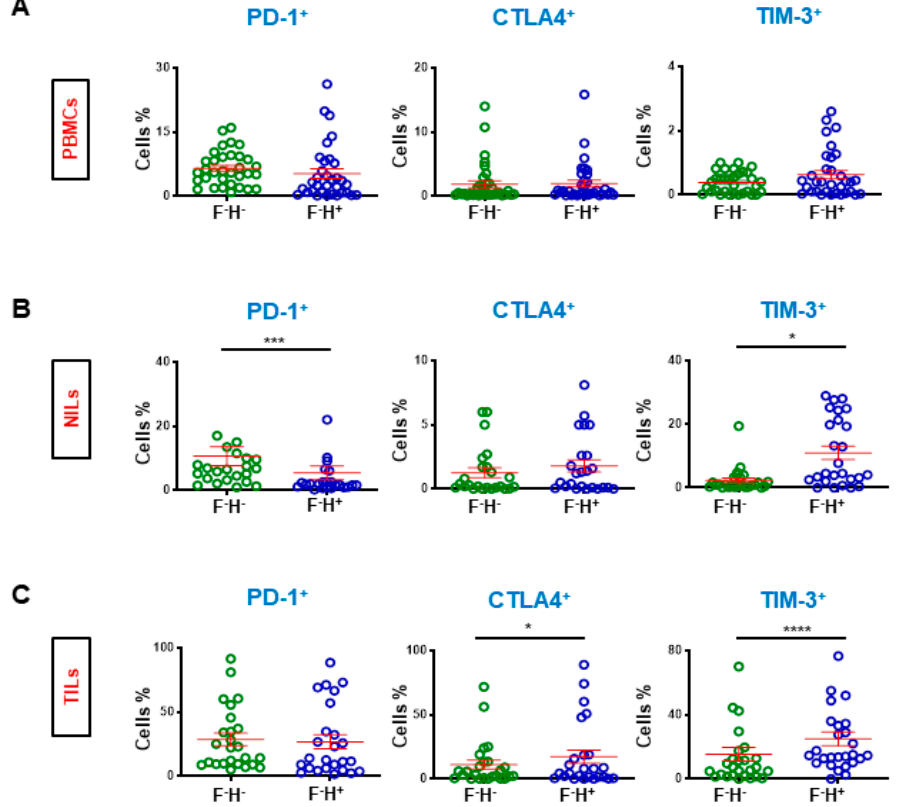
Figure 4. Comparison of different immune checkpoint expression on FoxP3 − Helios − and FoxP3 − Helios + in CD3 + CD4 − T cells. Patients were divided based on the expression of Helios. Scatter plots show the differences in levels of immune checkpoint expression on CD8 + FoxP3 − Helios − and CD8 + FoxP3 − Helios + T cells in PBMCs ( A ), NILs ( B ), and TILs ( C ). Statistical analysis are shown with significance levels indicated at * p < 0.05, *** p < 0.001 and **** p < 0.0001.